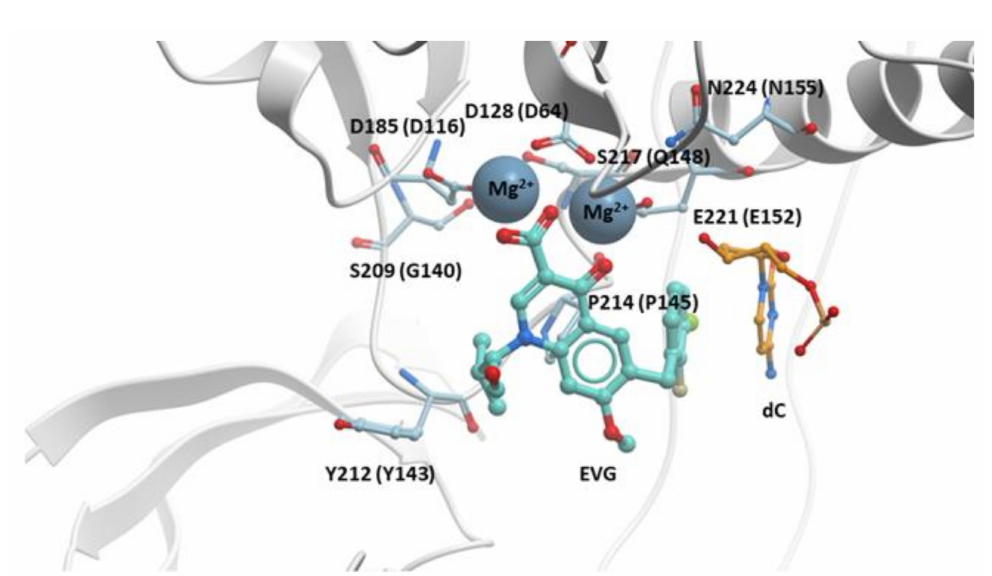
Figure 3. EVG in the active site of the PFV intasome. EVG (cyan) binding in the active site of the PFV intasome, chelating the Mg 2+ cofactors (gray). PFV IN is in white, and the penultimate cytosine near the 3 (cid:48) end of the viral DNA is in orange; the adenine on the 3 (cid:48) end of the viral DNA is omitted for clarity. PFV IN active residues D128, D185, and E221 are labeled (corresponding HIV-1 IN residues are given in parentheses). Additional IN residues that undergo resistance mutations are labeled with the corresponding HIV-1 IN residues given in